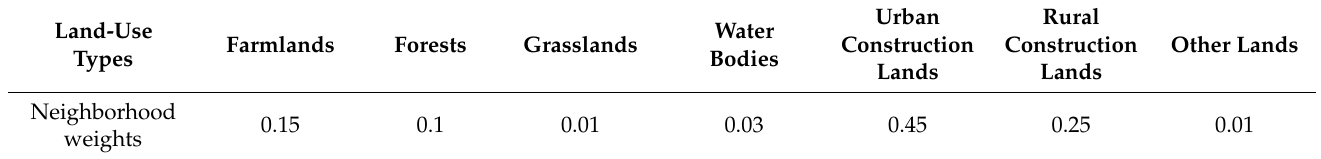
Table 2. Neighborhood weights of land-use